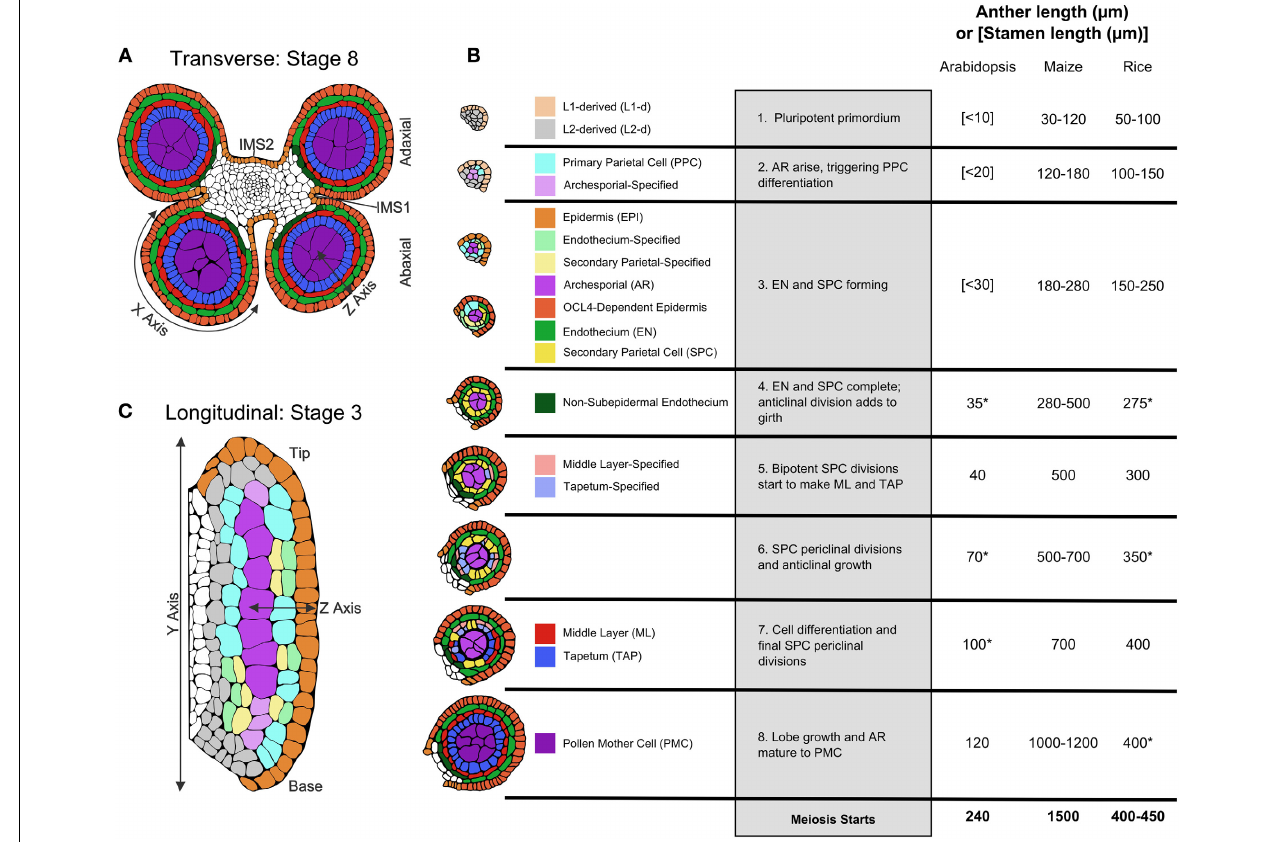
divisions in the EN (Vernoud et al., 2009) [stage 3]. Following these early patterning events that result in a three-layered wall surrounding the AR, there is a period of anticlinal division that expands anther cell number and organ size [stage 4]. Subsequently, each SPC divides once periclinally to generate the ML and TAP and the final four somatic walled architecture of the pre-meiotic anther lobe is achieved [stages 5–7]. Prior to meiosis, anticlinal divisions occur to increase anther size, and the individual cell types acquire differentiated properties [stages 6–8], including dramatic enlargement of AR as they mature into Pollen Mother Cells (PMC) capable of meiosis [stage 8]. Comparison of anther lengths at the 8 stages plus meiotic entry in Arabidopsis (Smyth et al., 1990; Sanders et al., 1999), maize (Kelliher and Walbot, 2014; Zhang et al., 2014), and rice (Zhang et al., 2011) is summarized in the table; lengths marked with an ( ∗ ) are inferred assuming linear growth in length in between known stages. (C) Longitudinal view of an anther lobe [stage 3] illustrates how AR column formation occurs simultaneously within both the tip and base of the lobe and that periclinal division of the PPC is stochastic. Parts of the illustrations in 1A,B are based on figures published in Zhang et al.